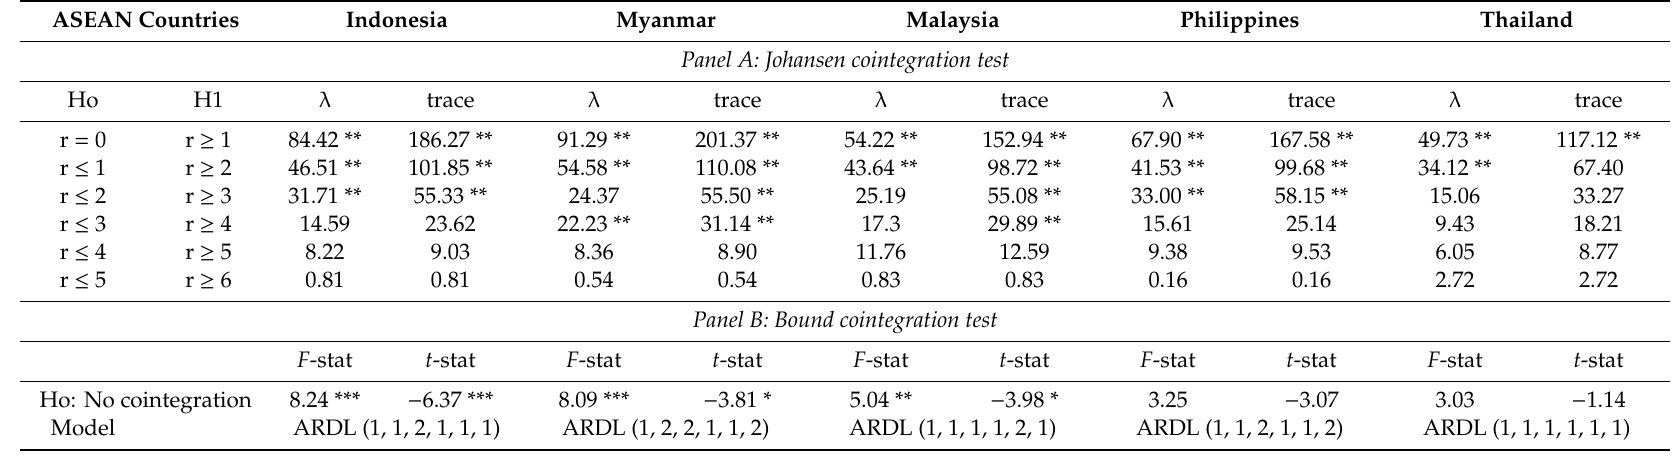
Table 3. Results of the cointegration